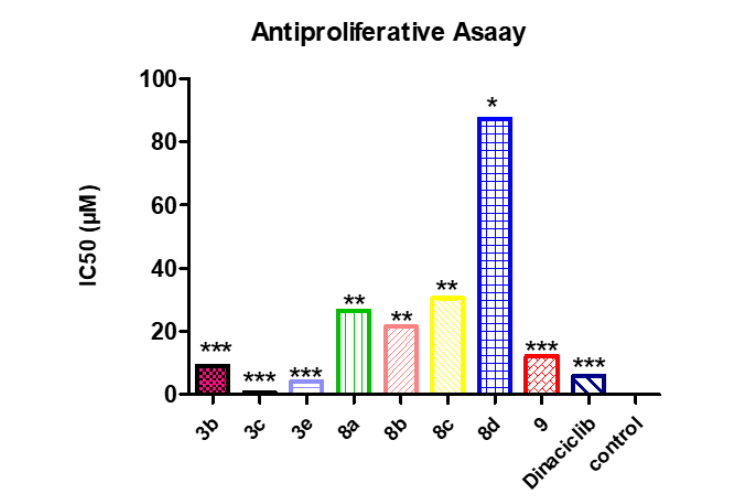
Figure 5. 3-(4,5-Dimethylthiazol-2-yl)-2,5-diphenyltetrazolium bromide (MTT) assay of 3b, 3c, 3e, 8a – d, 9, and Dinaciclib on the melanoma SK-MEL-5 cell line relative to the control. IC 50 : inhibitory concentration (50%). Results indicating at *, **, *** means less significant